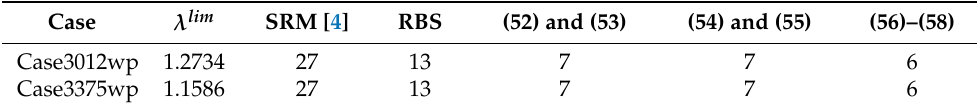
Table 4. Total iterations for ill-conditioned cases with limit load conditions.